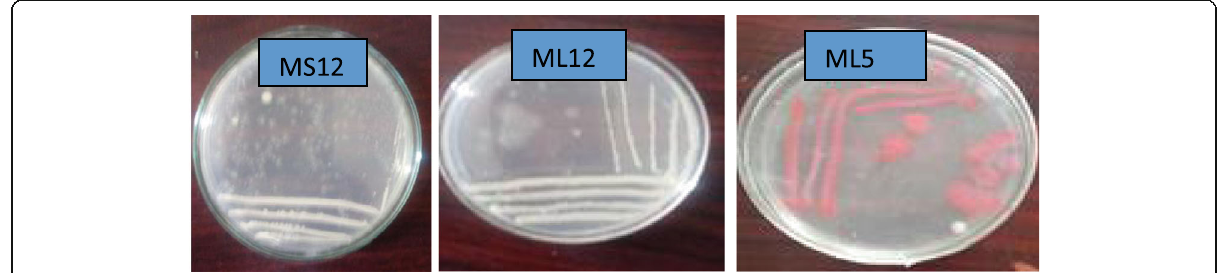
Fig. 2 Single colony isolation by streak plate